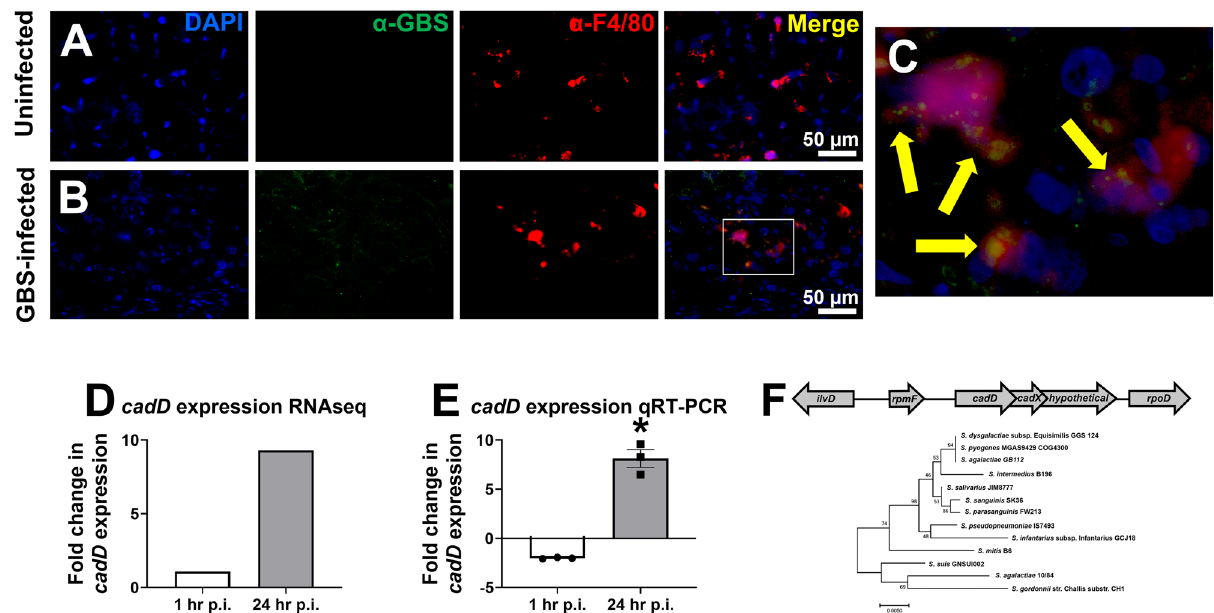
Fig.1|GBSlocalizeswithintissue-residentmacrophagesandexpresses cadD at